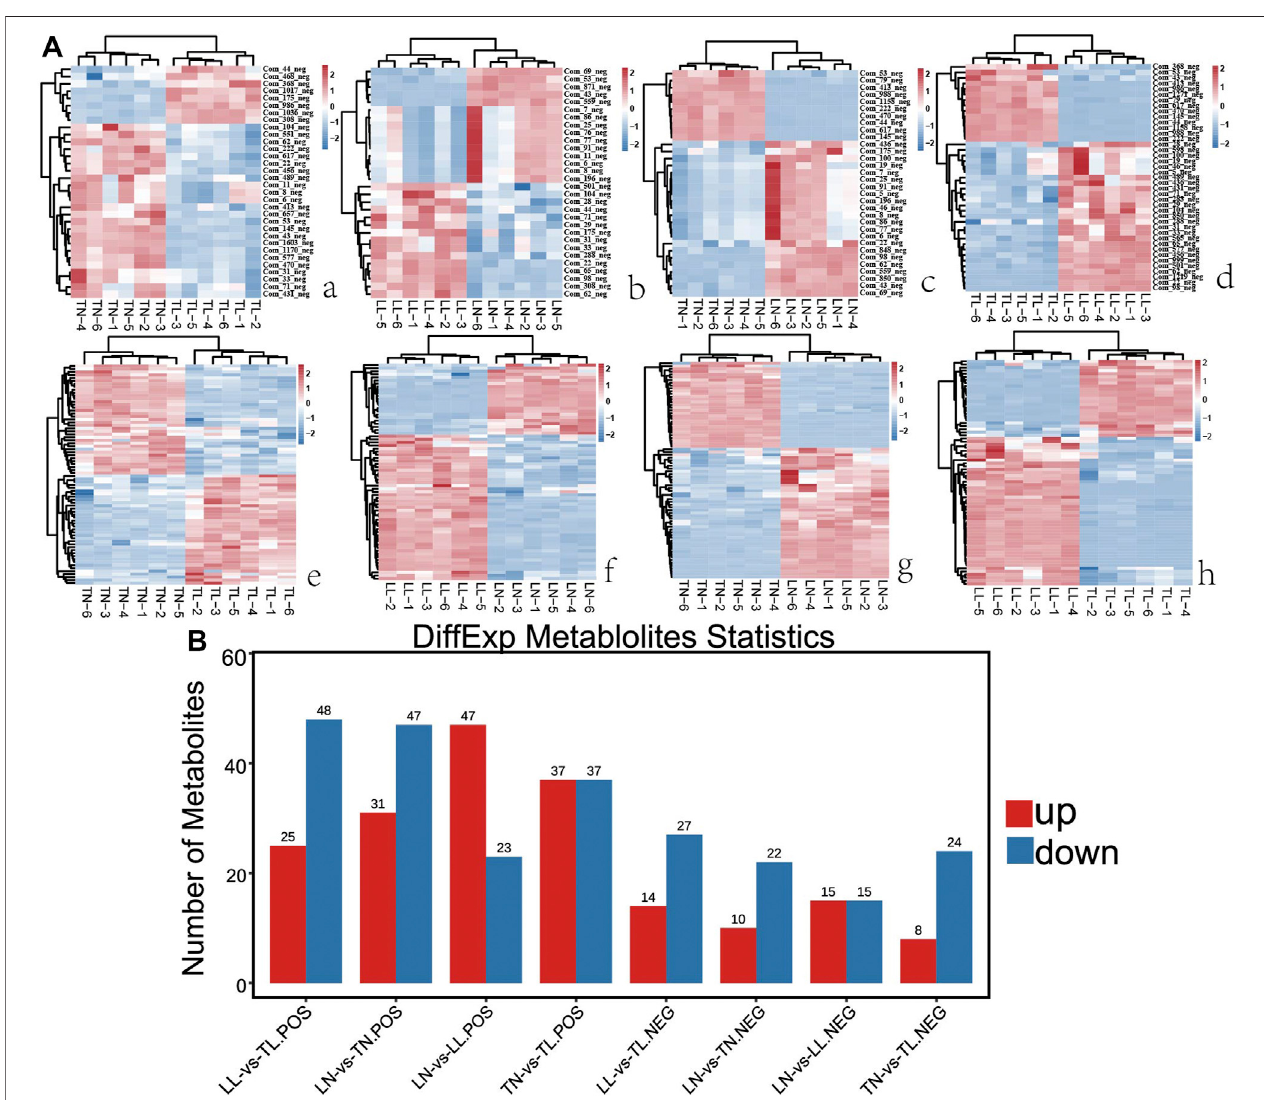
FIGURE 4 | Comparative analysis of DAMs expression among the four groups by metabolomic. (A) The heatmap shows the relative expression patterns of DAMs amongthefourgroups.Eachcolumnrepresentsasample,andeach rowrepresentstheexpressionlevelsofasinglemetabolomicinvarioussamples.Thecolorscaleof the heat map ranges from blue (low expression) to red (high expression). (a) Heatmap of DAMs for TN and TL groups. (b) Heatmap of DAMs for LN and LL groups. (c) Heatmap of DAMs for LN and TN groups. (d) Heatmap of DAMs for LL and TL groups. (B) The histogram shows the number of DAMs identi fi ed among the four